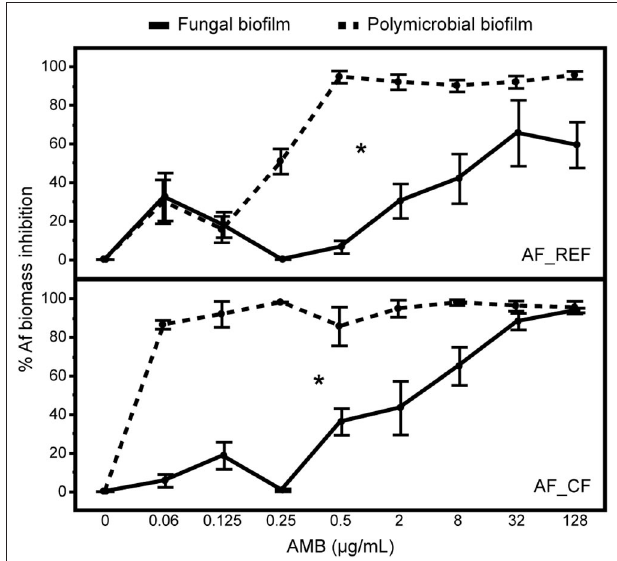
FIGURE 4 | Effects of amphotericin B on A. fumigatus in fungal and polymicrobial biofilms. Assessment of AMB activity on AF_REF or AF_CF in fungal (solid line) and polymicrobial (broken line) biofilms by qPCR. Percentages of biomass inhibition were calculated based on untreated biofilms results. * p < 0.05; Af, A. fumigatus ; AMB, amphotericin